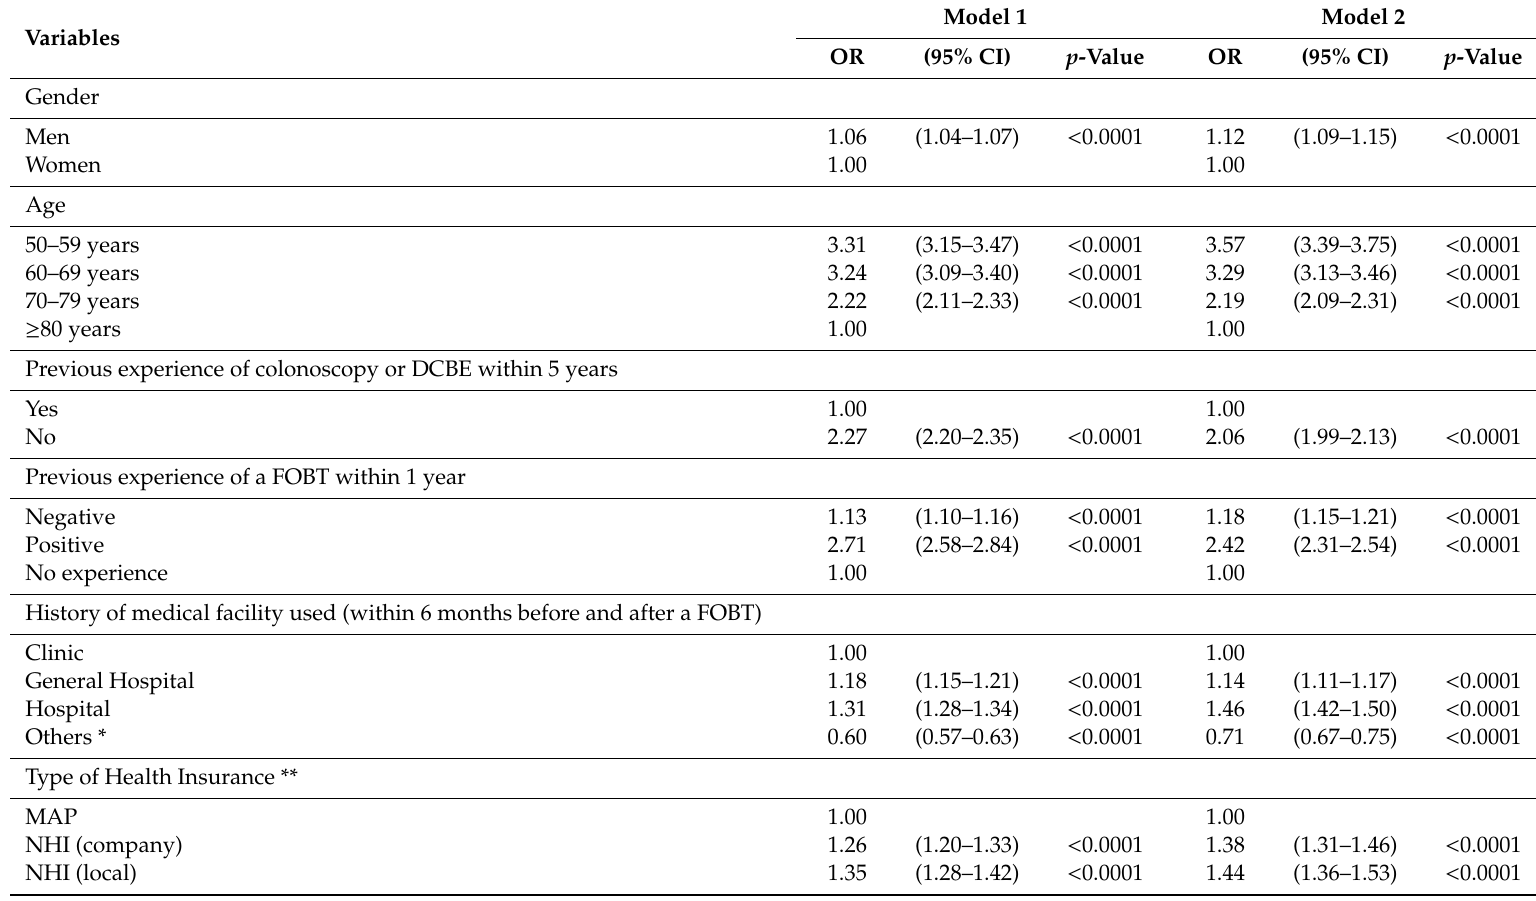
Table 2. Clinical factors associated with adherence to the follow-up test after a positive FOBT by multivariable